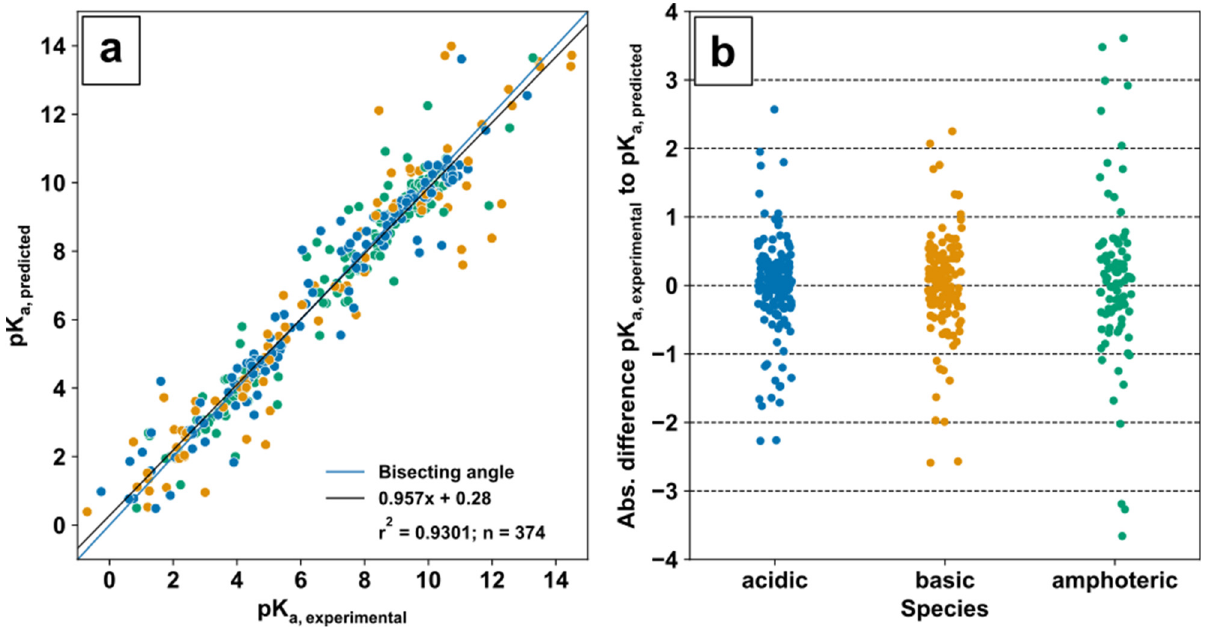
Figure 2. Evaluation of pK a prediction for acidic, basic, and amphoteric species: Experimental pK a values were obtained from [76] ( a ); Bisecting angle and linear regression of experimental and predicted pK a values; ( b ) Absolute difference of predicted pK a to experimental pK a values.